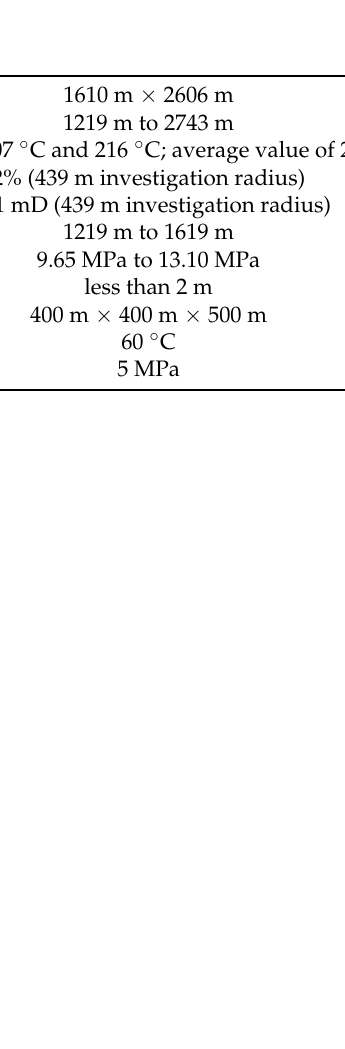
Table 1. the Parameters of the DP32-1 Site [43].